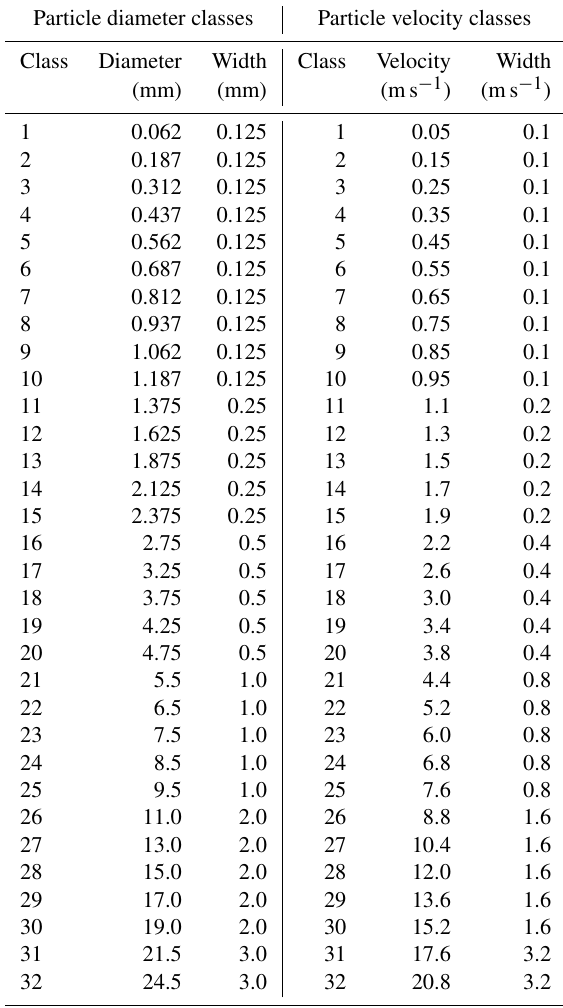
Table 2. Definition of the classes of particle size and velocity for the Parsivel 2